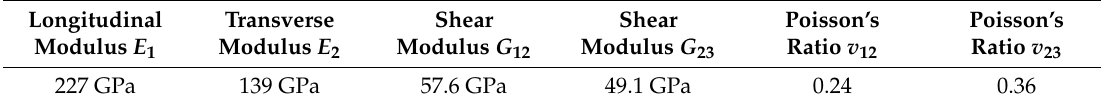
Table 1. Material properties of Boron/Al [27].